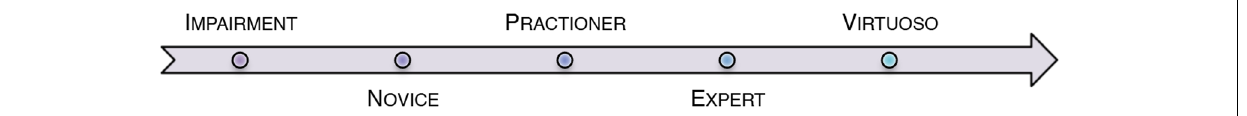
virtuoso performer will exhibit the highest levels of complex hand dexterity in their given